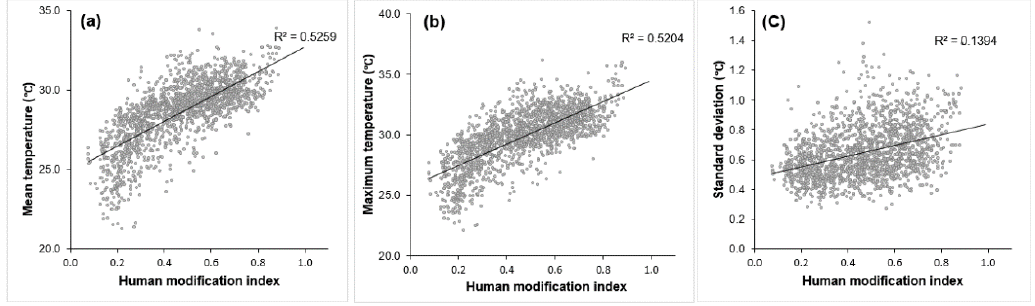
Figure 7. Correlation between temperature (mean ( a ), maximum ( b ) and standard deviation ( c )) and human modification index.